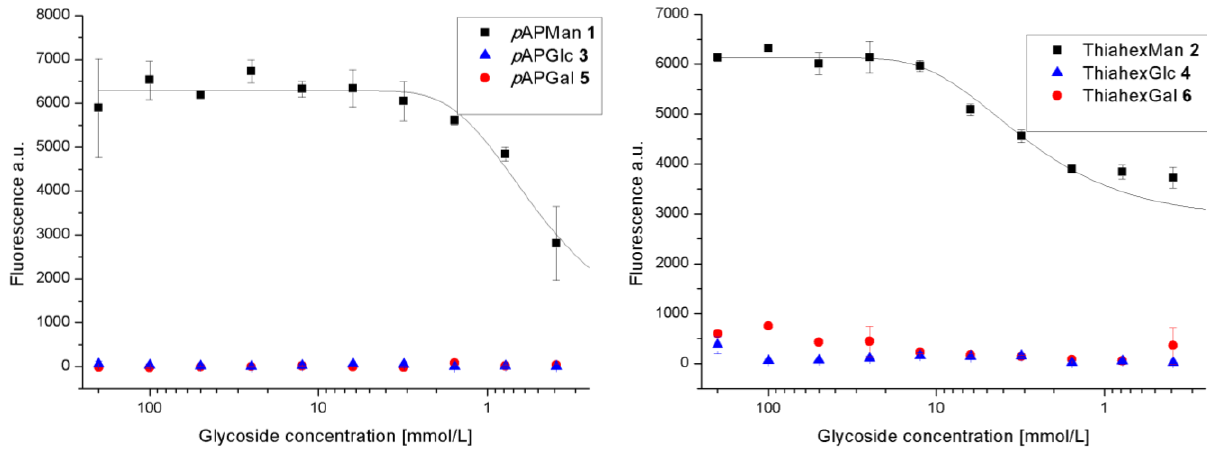
Figure 4. Bacterial binding to glycoarrays on microtiter plates. Various concentrations of glycosides were used for surface functionalization. The depicted binding curves are representative examples from several (>3x) independent experiments. Error bars result from duplicate values on one